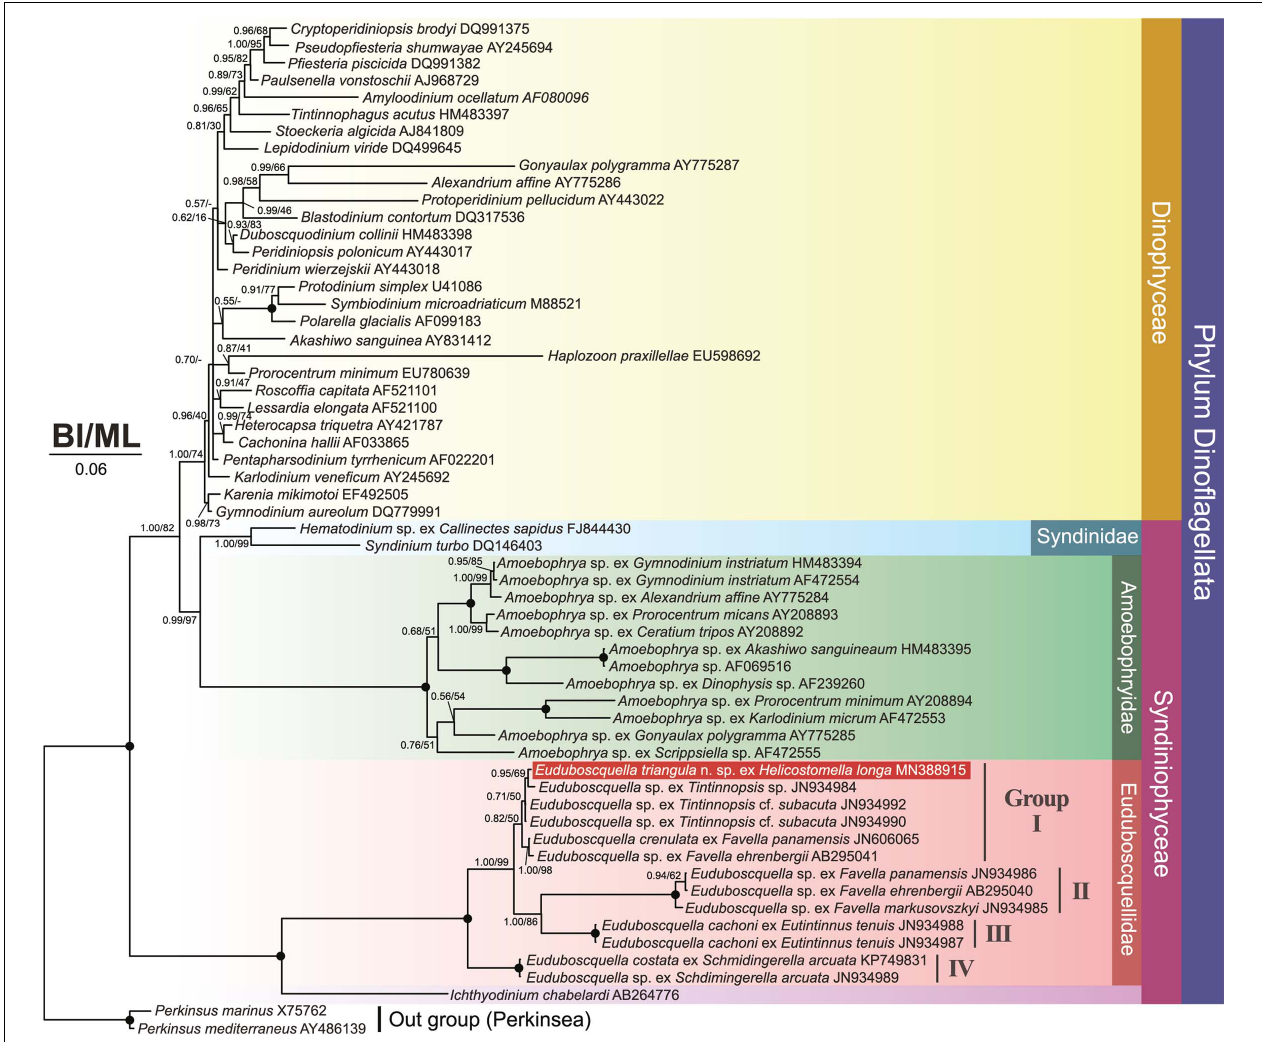
FIGURE 6 | Bayesian interference (BI)/maximum likelihood (ML) phylogenetic trees inferred from SSU rDNA sequences (1606 bp). The tree contains 59 sequences of which 13 represent Euduboscquella species from known host taxa. The novel sequence for Euduboscquella triangula is indicated in white font. Posterior probabilities/bootstrap values for interior branches are shown for BI and ML trees, respectively. Fully supported branches (1.00/100%) are indicated by solid circles at branch nodes. Disagreements in BI and ML tree topology are indicated by a dash (–). Scale bar indicates six base substitutions per 100